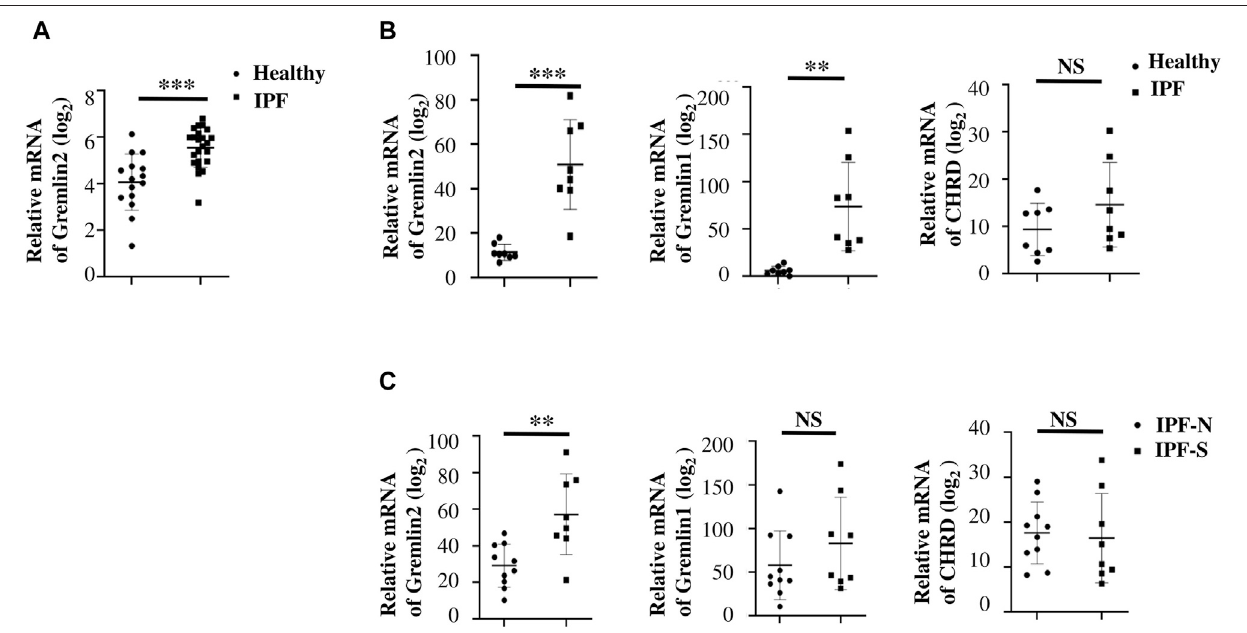
FIGURE 1 | High expression of Gremlin2 in the fi brotic area obtained from IPF databases (A) The mRNA expression of Gremlin2 in patients with IPF and healthy people in database GSE10667. The data has been log 2 processed. (B) The mRNA expression levels of Gremlin2, Gremlin1, and CHORD in the lung tissues of eight IPF patientsandeighthealthypeopleusingtheGSE99621database.Thedatahasbeenlog 2 processed. (C) mRNAexpressionlevelsofGremlin2,Gremlin1,andCHORDin the GSE99621 database in the scar regions of eight IPF patients and ten non-scar regions of patients with IPF. The data has been log2 processed.NS stands for p > 0.05, * p < 0.05, ** p < 0.01, *** p < 0.001. Student ’ s t-test was used for statistics. IPF-N, non- fi brosis lung area of IPF patients; IPF-S, fi brosis lung area of patients with